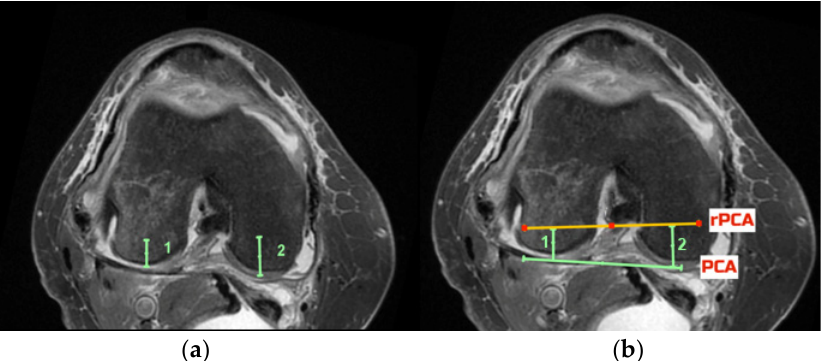
Figure 2. Defining the preartrhitic posterior condylar axis (PCA) and the resected posterior condylar axis (rPCA). ( a ): Using the measured navigated resection depth data, the respective distance from the posterior condyles was marked, and a point signifying the depth of the resection was defined on each condyle (in this case, distance 1: 4 mm, and distance 2: 6 mm). ( b ) The line connecting these two points was the prosthetic posterior condylar axis (rPCA, yellow). The rPCA corresponds to the placement of the femoral component and is parallel to the implant’s posterior condylar axis. The posterior condylar axis (PCA) was defined as the tangent to the posterior condyles after allowing for up to 2 mm correction in case of cartilage loss, as evident on the MRI (green